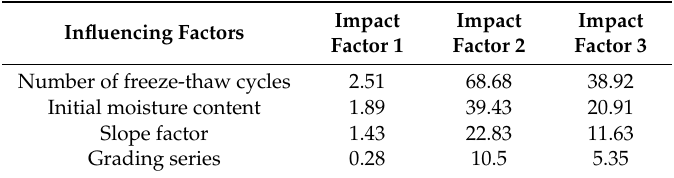
Figure 2. Numerical calculation model of the cutting slope (unit: m). Table 2. Factors a ff ecting slope